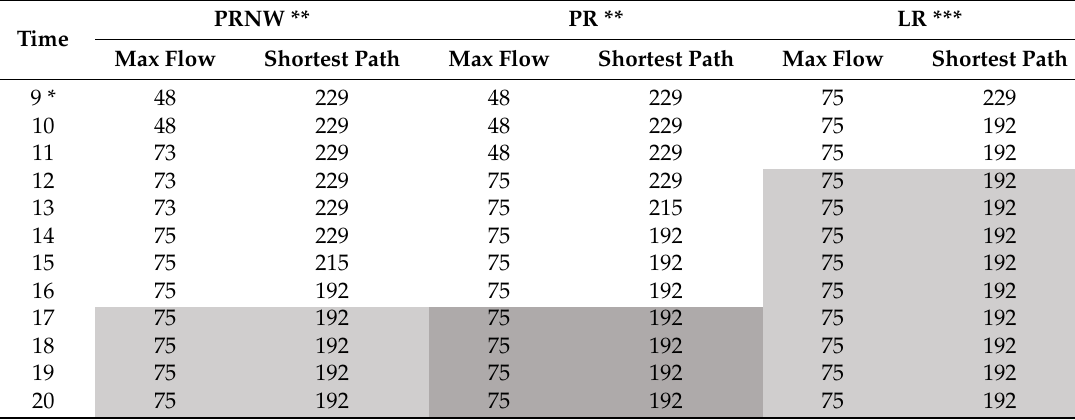
Table 3. Changes of max flow and shortest path distance during recovery (shaded area indicates that the recovered state was